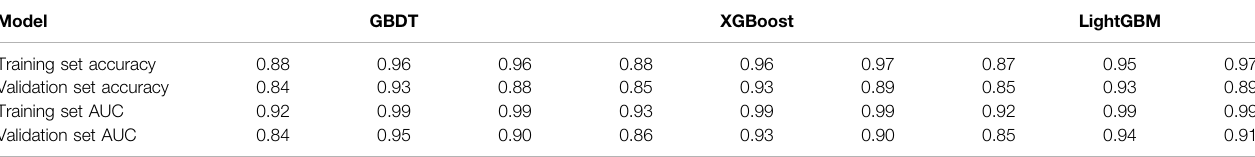
TABLE 7 | The accuracy and AUC statistics of the three models of the three fungi. Model GBDT XGBoost LightGBM Training set